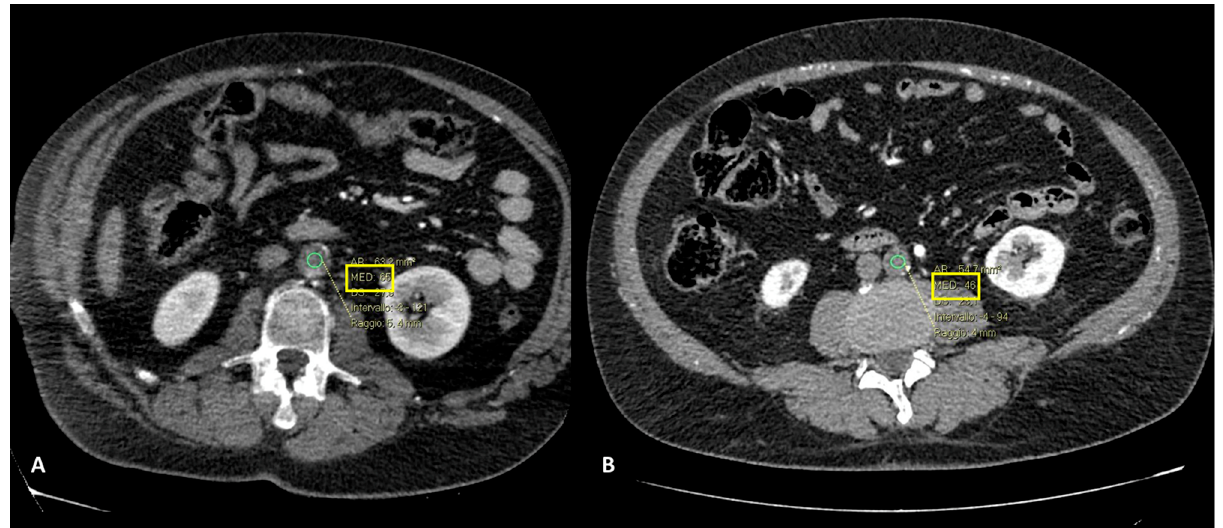
Figure 6. CT angiography, axial planes, arterial phase. In ( A ), the ROI placed in the aortic thrombus showed a value of 65 HU, while in ( B ), the value showed was 46 HU. Patient in ( A ) presented a chronic aortic occlusion while patient in ( B ) was one of the patients included in our study, affected by primary AAO (male, age 54 y/o).